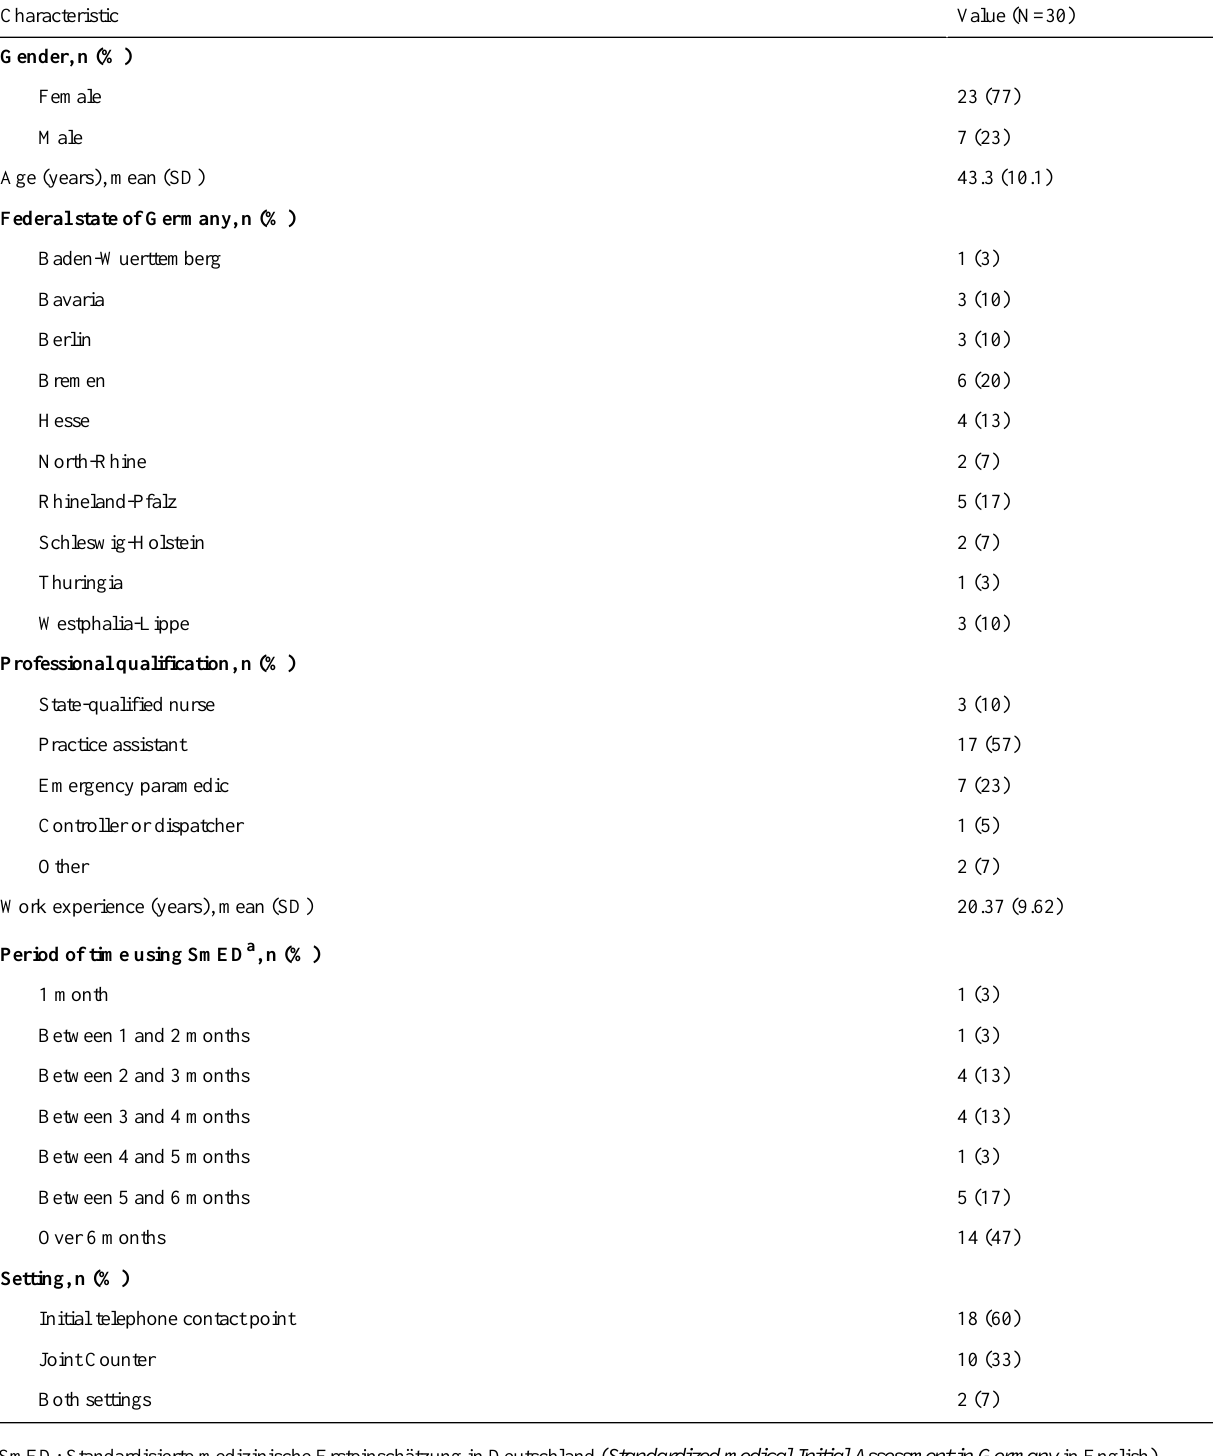
Table 1. Characteristics of health care